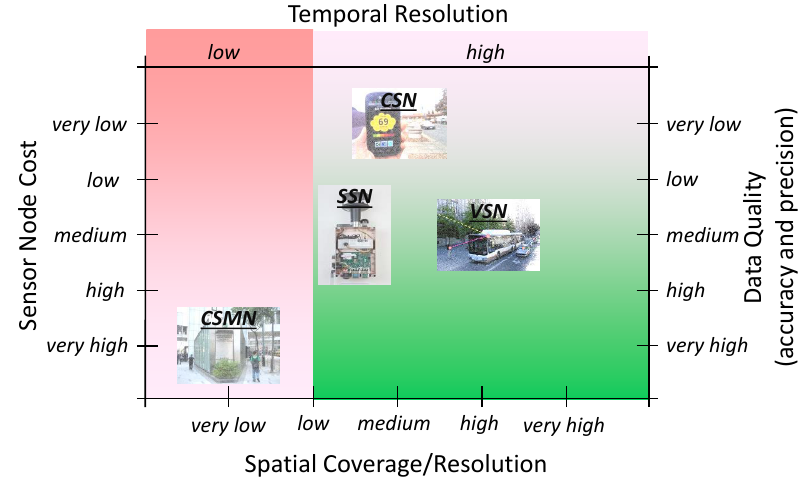
Figure 7. Trade-off between tolerable sensor node cost, obtainable measurement coverage/resolution, expected data quality and achievable measurement temporal resolution for Conventional Stationary Monitoring Network (CSMN), Static Sensor Network (SSN), Community Sensor Network (CSN) and Vehicle Sensor Network (VSN)